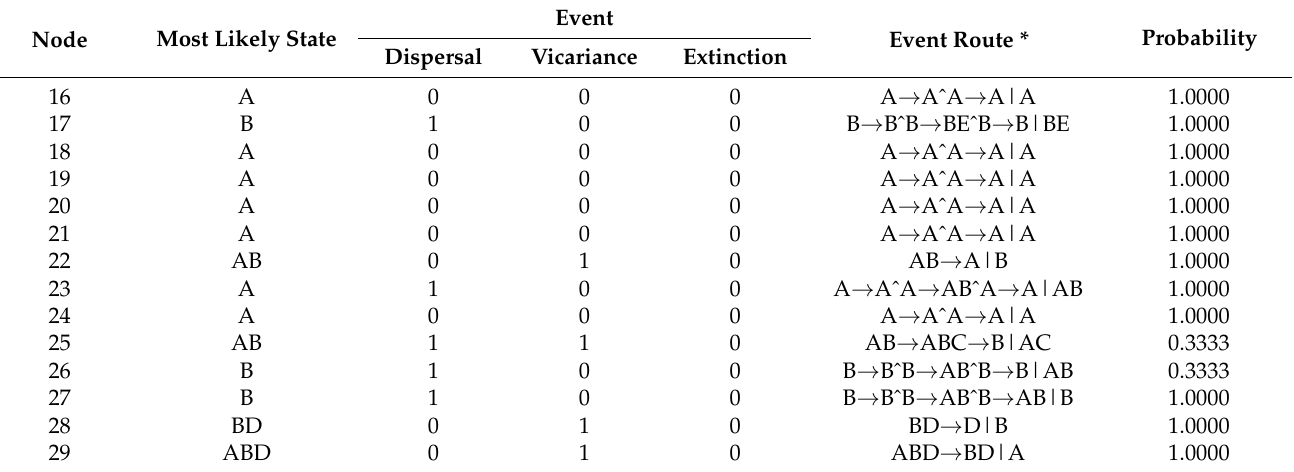
Figure 3. A reconstruction of ancestral areas (A: NE Oriental region; B: Sundaland; C: the Philippines; D: Wallacea; E: Australian region) in the C. gigantea group and the C. cristata group (out-group). The most likely state on each of the ancestral nodes (#16–29) is represented with a color/letter or color/letter combination. Distributions of extant fly species are mapped onto terminal nodes. Table 5. Summary of the results of the S-DIVA analysis of ancestral distribution in the C. gigantea species